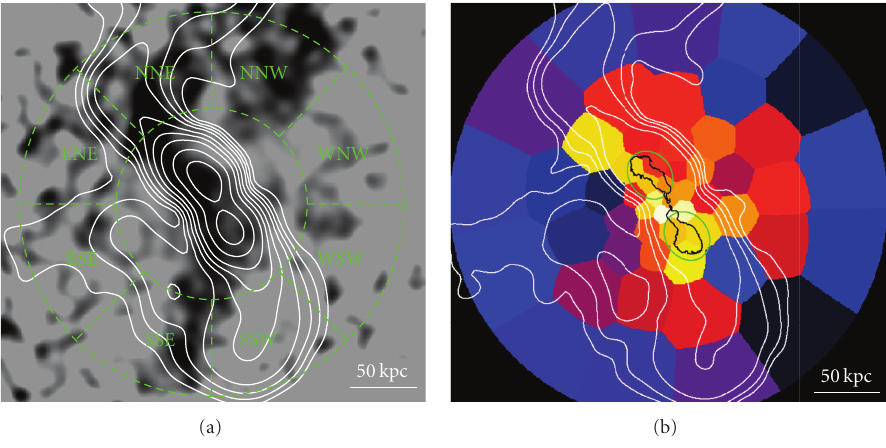
Figure 6: (a) High-contrast hardness ratio map of the galaxy cluster Hydra A obtained by dividing a 1.5–7.5 keV image by a 0.3–1.5 keV image. Regions in black are indicative of low temperature gas, indicating the presence of low-entropy filaments. Overlaid in green are the sectors used to study the spectral properties of the cool gas (located between radii ∼ 70–150 kpc). Gitti et al. [120] extracted the spectra in these sectors and compared two di ff erent spectral models: a single-temperature plasma “1T” model, and a “2T” model which includes a second thermal emission component. The F statistics for the spectral fitting improvement over the single-phase model indicate that the addition of a second thermal component is most significant in sectors SSE, NNW, NNE, and ENE, thus providing evidence for the presence of multiphase gas in agreement with the hardness ratio map. Adapted from Gitti et al. [120]. (b) Metallicity map showing the central 5 (cid:11) × 5 (cid:11) of Hydra A. Brighter regions represent a higher metallicity. The color scale of the metallicity Z (in solar units) is as follows: white: Z ≥ 0 . 75, yellow: Z = 0 . 65–0 . 75, orange: Z = 0 . 55–0 . 65, red: Z = 0 . 45–0 . 55, blue: Z = 0 . 3–0 . 45, and black: Z ≤ 0 . 3. The 1.4 GHz radio emission is shown by the black contours. The green elliptical regions indicate the position of the inner cavities. Adapted from Kirkpatrick et al. [119]. In both panels are overlaid the white contours outlining the 330 MHz radio emission from Lane et al.